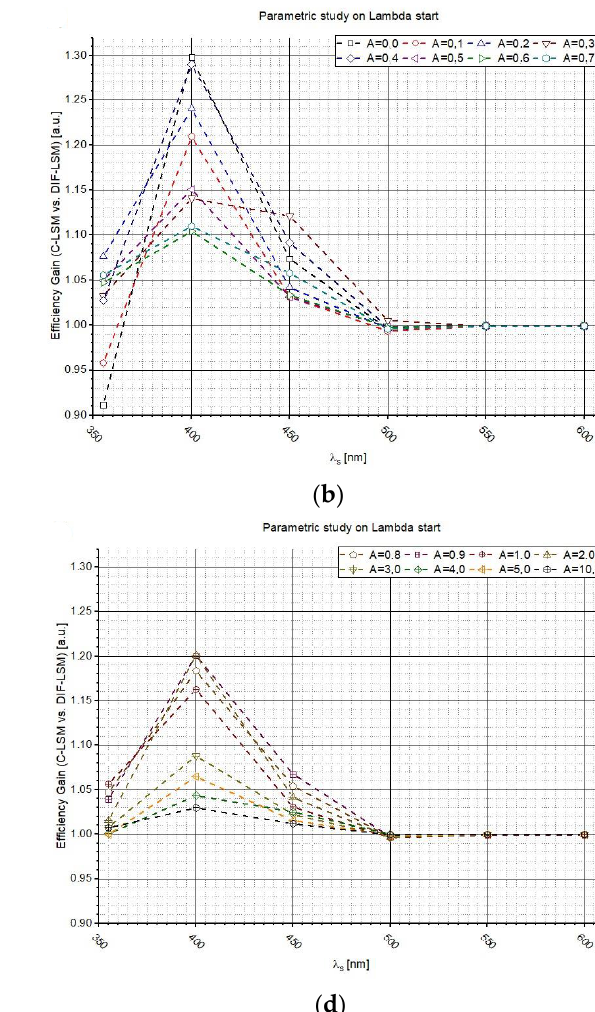
7 of 16 Figure 2. Efficiency gain (P) of the C-LSM algorithm versus the W DIF -LSM algorithm. In the plot are reported the trend of the efficiency gain through the two algorithms as a function of the increase in the fundamental parameter A . Then, three different studies were conducted to examine the influence of external factors on the algorithms, such as the shape of spectra or the concentration. The first study was conducted by varying the σ value to change the shape of the second spectrum (taking constant the shape of the first spectrum and the concentrations). The tests were repeated sixteen times, varying parameter A every time (from 0 to 10 a.u.). The second study was conducted always changing the shape of the second spectrum, but in this case, the variable